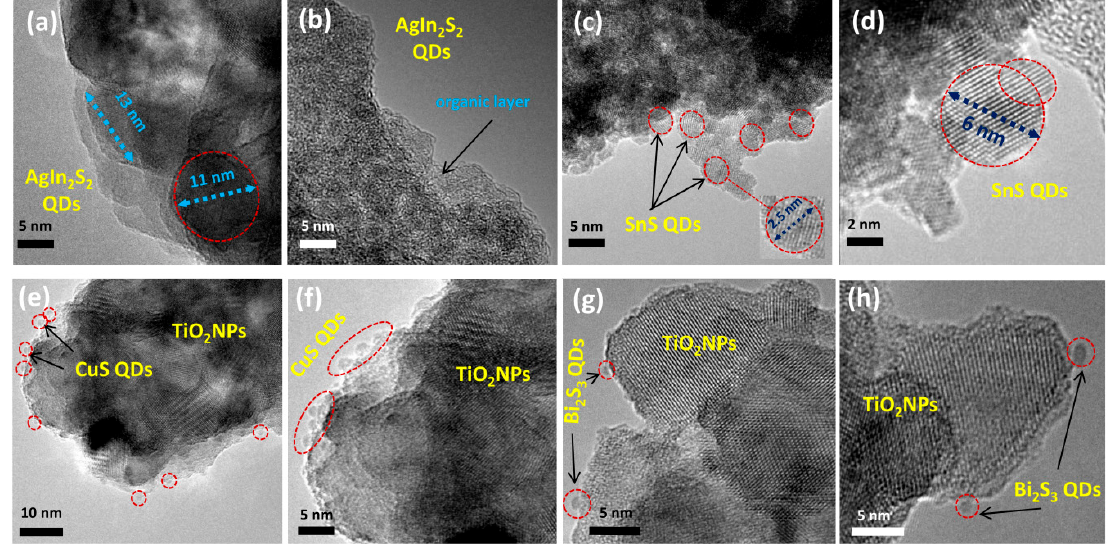
Figure 2. HR-TEM images for ( a , b ) AgInS 2 QDs, ( c , d ) SnS QDs, ( e , f ) TiO 2 / CuS_15 QDs, and ( g , h ) TiO 2 / Bi 2 S 3 _15 QDs.